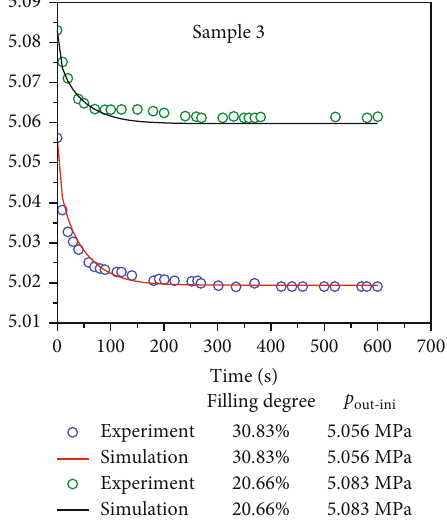
Figure 7: The experimental and simulative results for Sample 3 with 30.83% and 20.66% fi lling degrees, at 5 MPa and 303.15K.